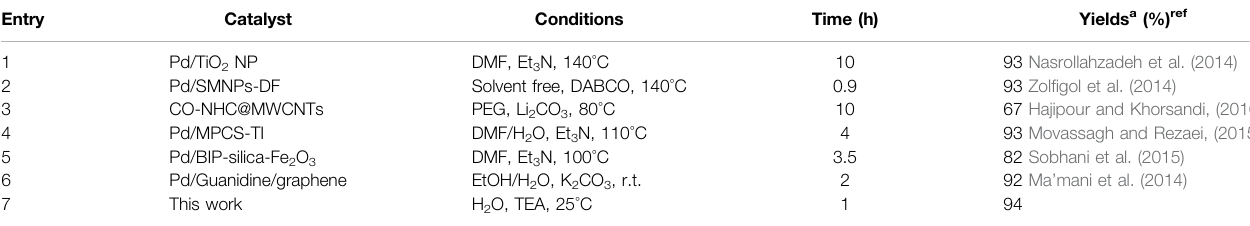
TABLE 5 | Comparison of the catalytic activity of Pd@Py 2 PZ@MSN with the previously reported